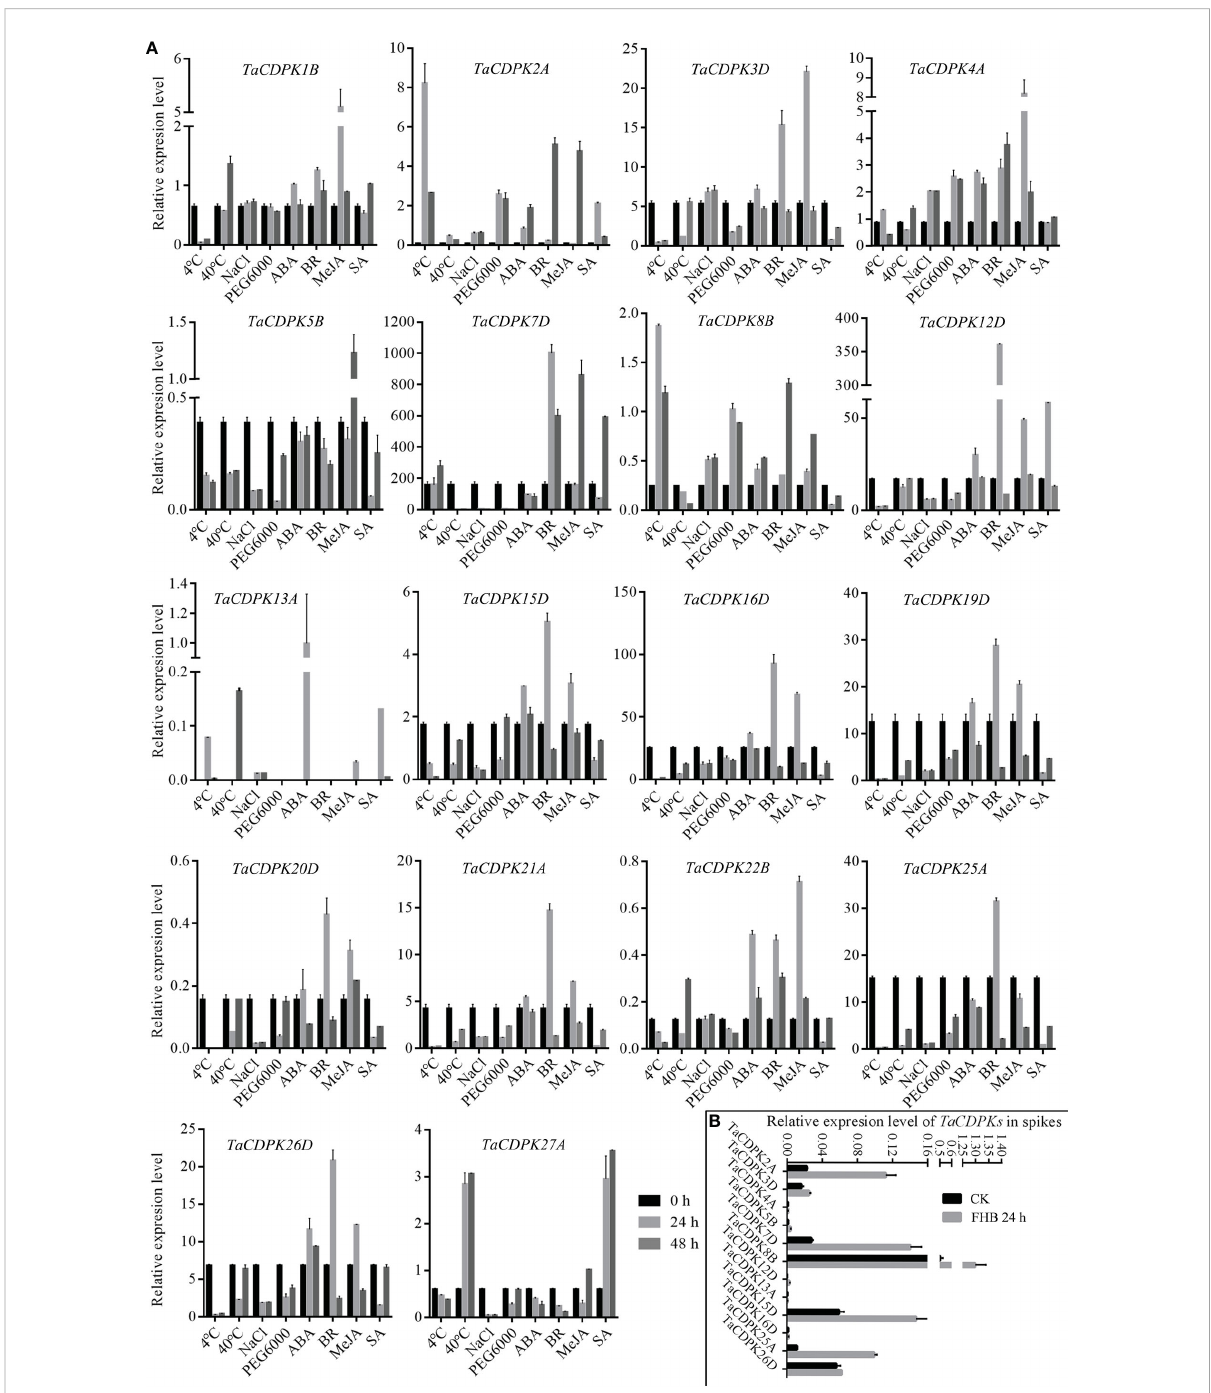
FIGURE 6 Inducible expression pro fi les of TaCDPKs in wheat by qRT-PCR. (A) The inducible expression patterns performed by qRT-PCR under cold (4°C), heat (40°C), 20 % PEG6000, salt (200 mM NaCl), ABA (100 m M), SA (500 m M), MeJA (100 m M) hormone treatments. In all treatments, the heat (40°C) treatment lasted for 12 h and 24 h, respectively, instead of 24 h and 48 h as indicated in the (A) . The 10-day old hydroponic seedlings were used for the analysis. (B) Inducible expression pro fi les of TaCDPKs in wheat spike treated with Fusarium graminae spore suspension for 24 h. The expression level of every gene is the mean of results from three independent experiments, each having three or four replicates. CK: the control group; FHB: the experimental group treated with Fusarium graminae spore suspension, which are associated with Fusarium Head Blight